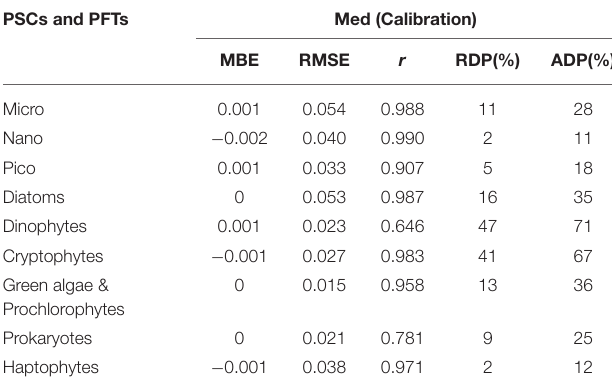
TABLE 6 | Statistical results of the new regional algorithms (Med) applied to the calibration dataset (70% of the entire subset = 966 data). PSCs and